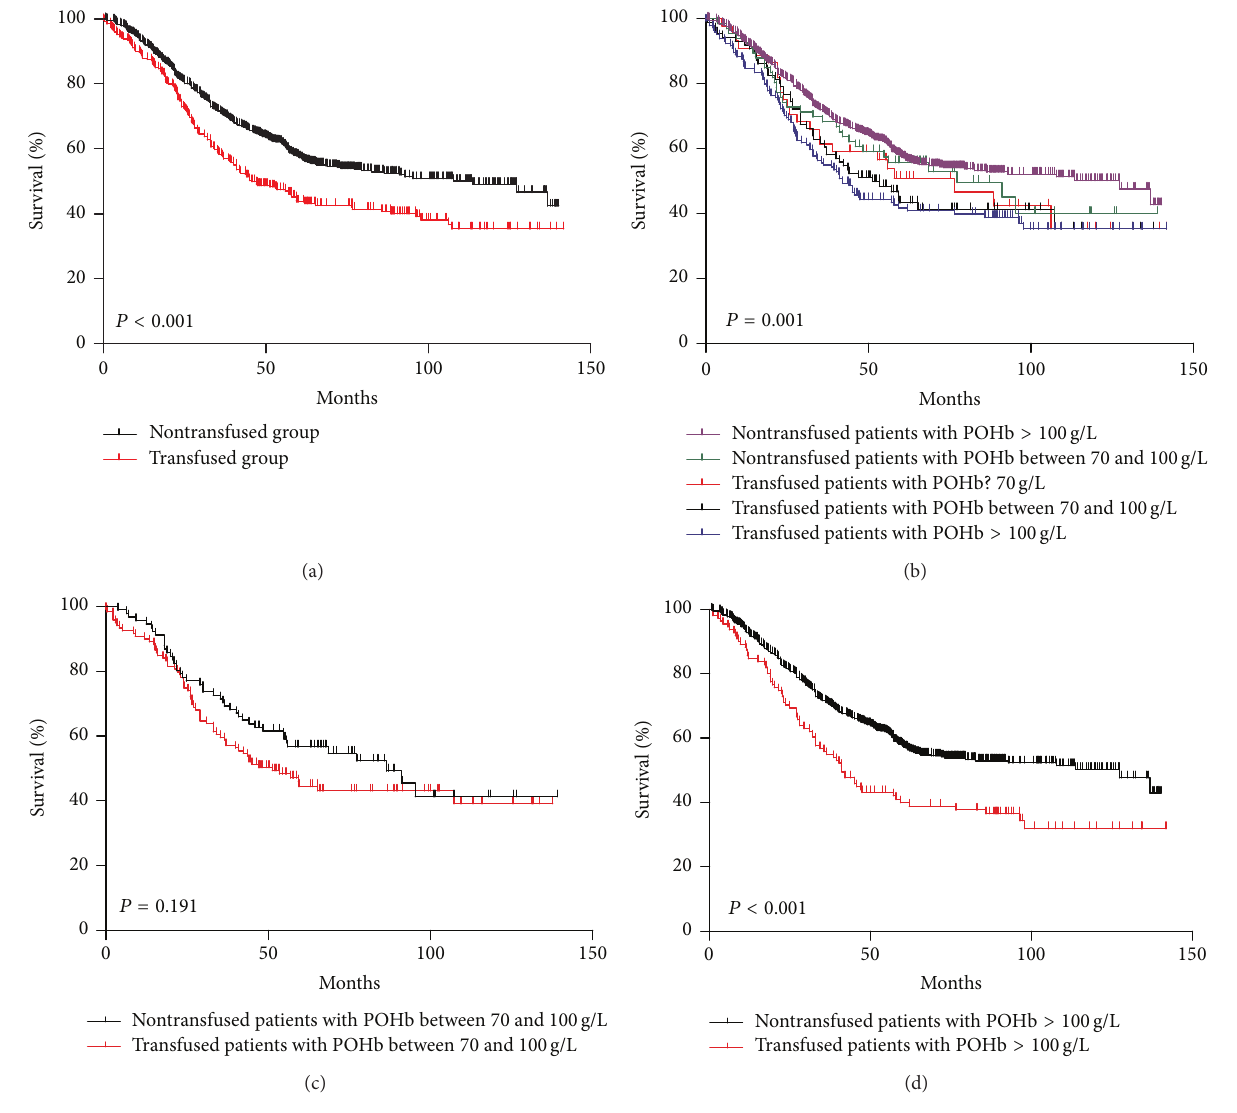
Figure 1: (a) Survival analysis of transfused and nontransfused patients. (b) Survival analysis of transfused and nontransfused patients with different POHb. (c) Survival analysis of transfused and nontransfused patients with POHb between 70 and 100g/L. (d) Survival analysis of transfused and nontransfused patients with POHb >